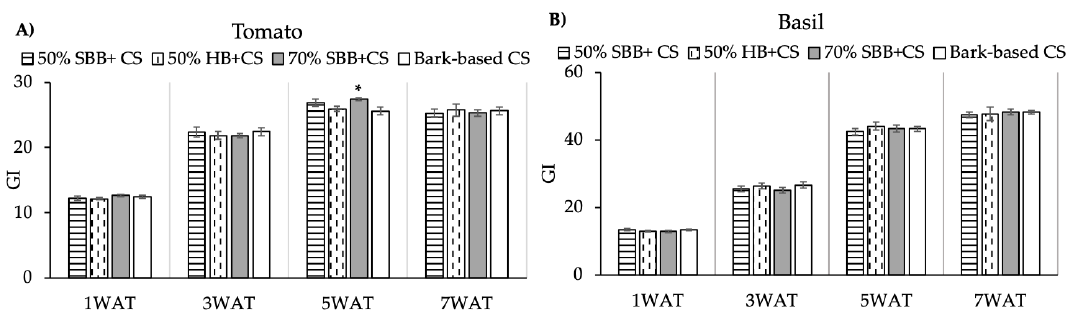
Figure 4. Growth index (mean ± standard error) of plants tomato ( A ) and basil ( B ) grown in container mixes with 50% sugarcane bagasse biochar (SBB), 50% mixed hardwood biochar (HB), and 70% SBB (by vol.) mixed with bark-based commercial substrate (CS) at 1, 3, 5, and 7 week(s) after transplantation (WAT). *indicated significant differences from CS, using Dunnett’s test at p ≤ 0.05.